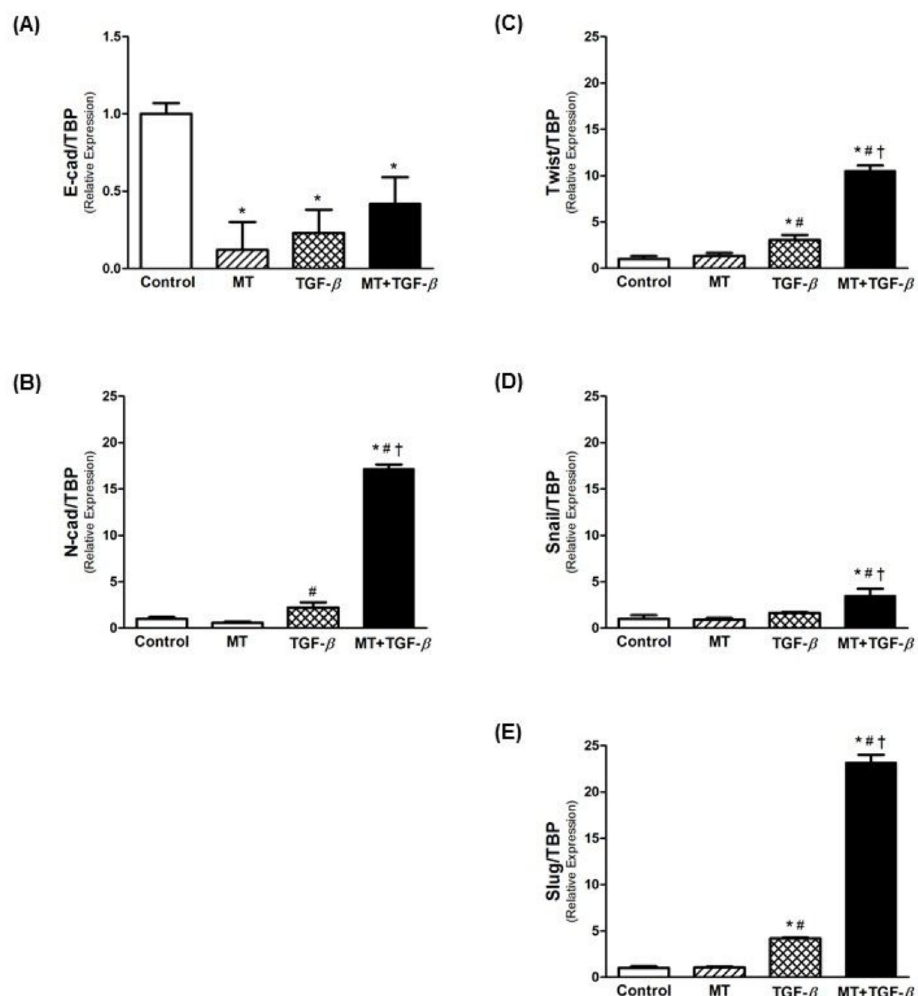
Fig 3. Real-time PCR for EMT markers. Relative mRNA levels of (A) E-cadherin (epithelial marker), (B) N- cadherin (mesenchymal marker), and (C-E) EMT-associated transcriptional factors (Twist, Snail and Slug). Association of MT and TGF- β 1 potentiated EMT in T24 cells, decreasing E-cadherin expression and upregulating inductor genes of EMT. * p < 0.05 vs. Control; # p < 0.05 vs. MT; † p < 0.05 vs. TGF- β